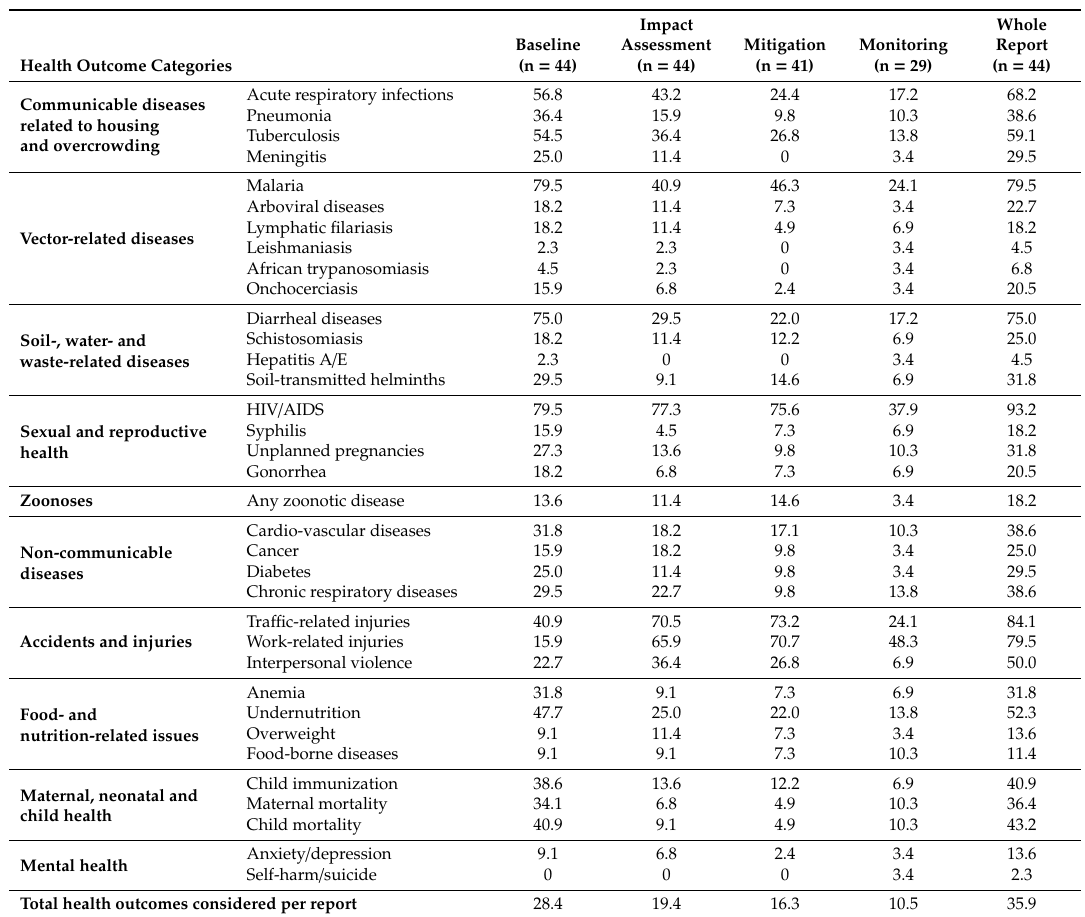
Table A4. Inclusion of health outcomes in impact assessment